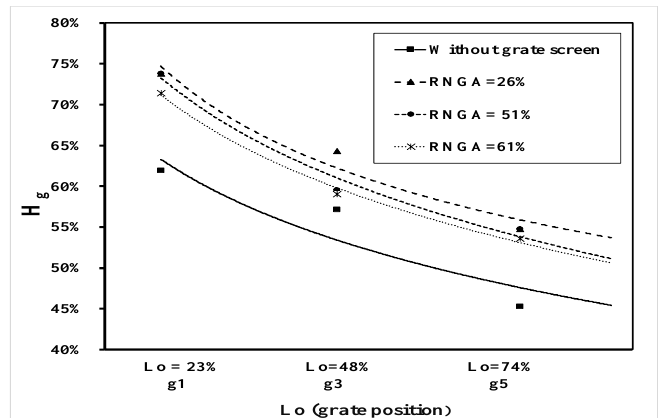
Figure 13. Relationship between relative grate water height and relative grate distance for different grate inlet areas at (Q = 6.0 L/s).